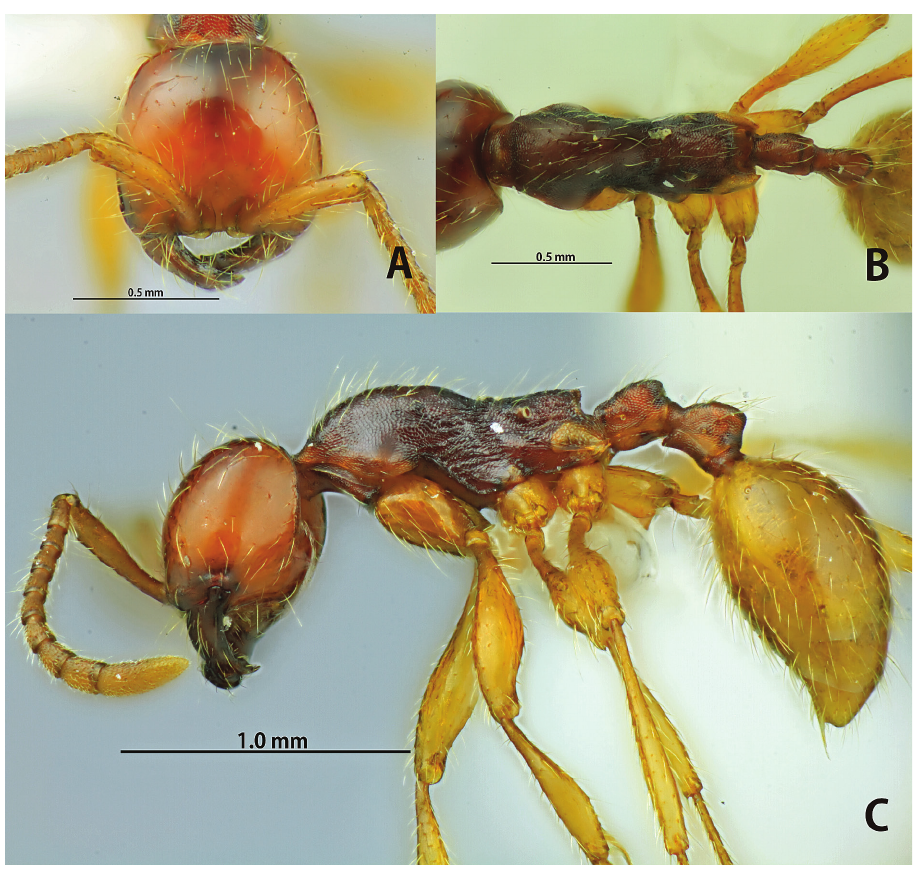
Figure 8. Aenictus fuchuanensis (non-type from Hong Kong). A Head in full-face view B body in dorsal view C body in